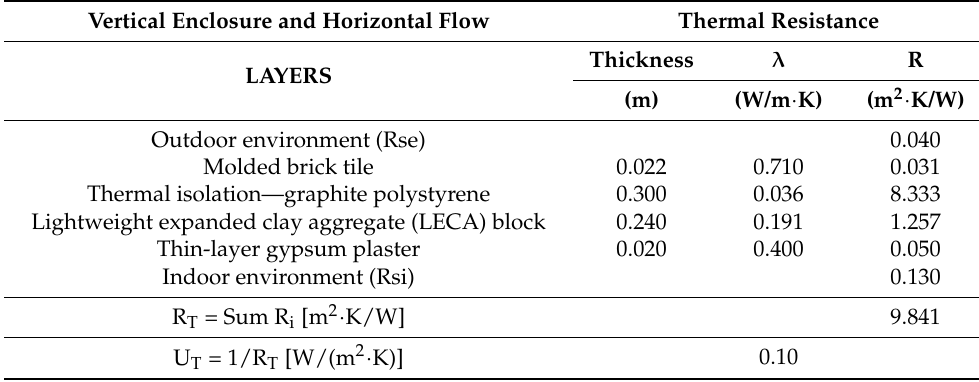
Table 2. U -value of heat transfer coefficient for the wall— U w .